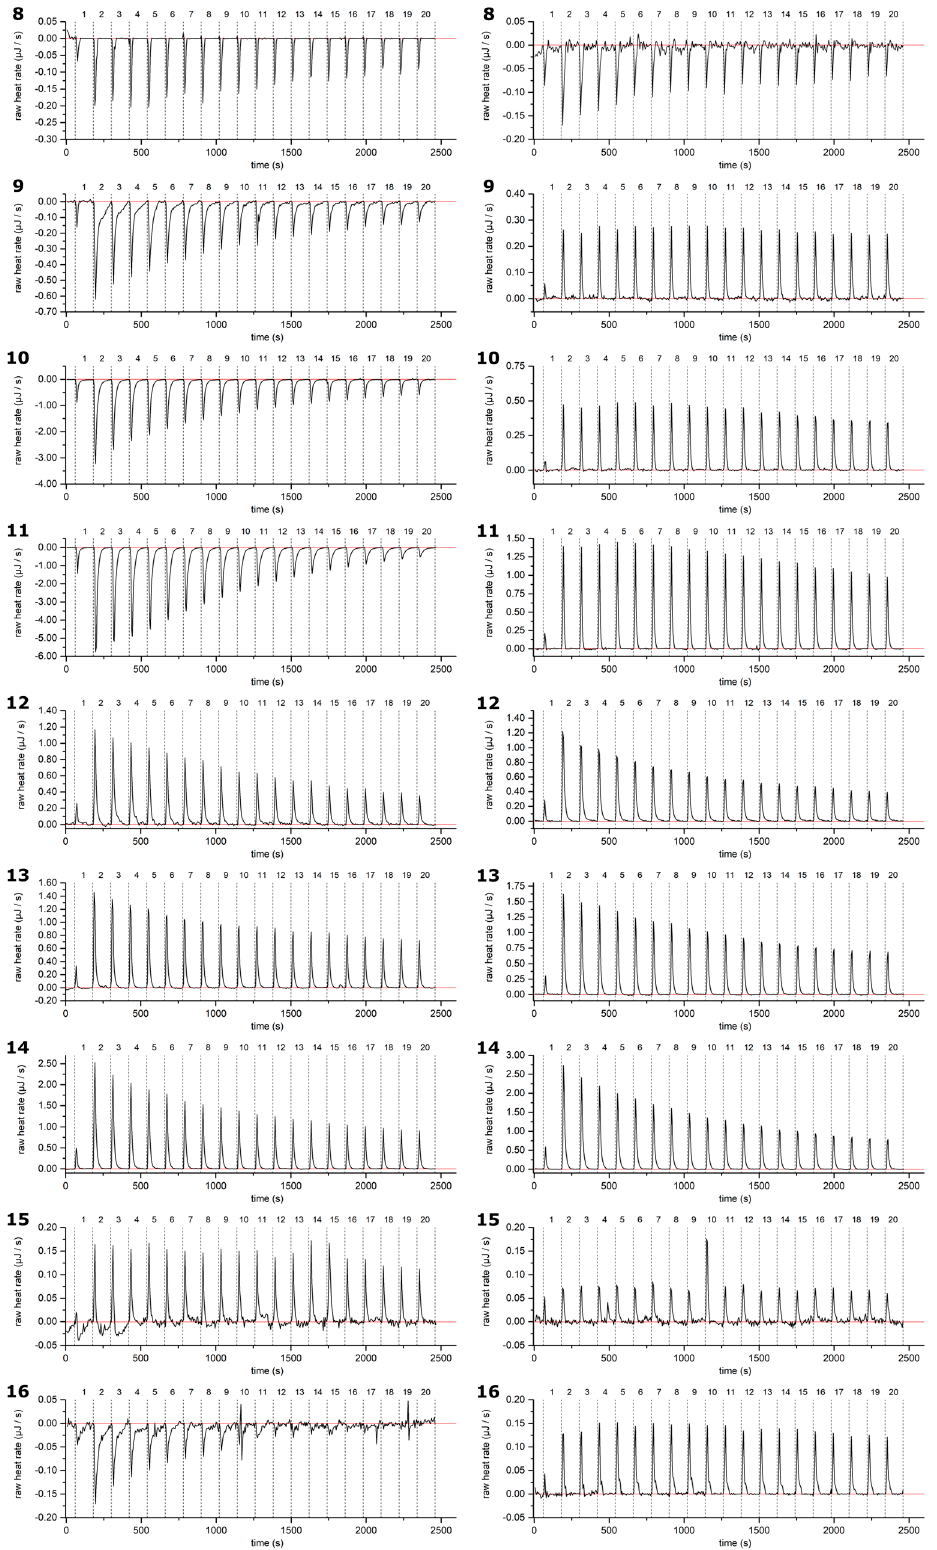
Figure A2. Example thermograms of HTs 8 – 16 sample ( left ) and control ( right , HT titrated into buffer solution): measurements plotted against measurement time. Corrected baseline presented as a red line, and injections separated with dashed lines. HTs are presented in order of ascending molecular weight. For the structures and numbering of HTs, refer to Figures 1 and 2.